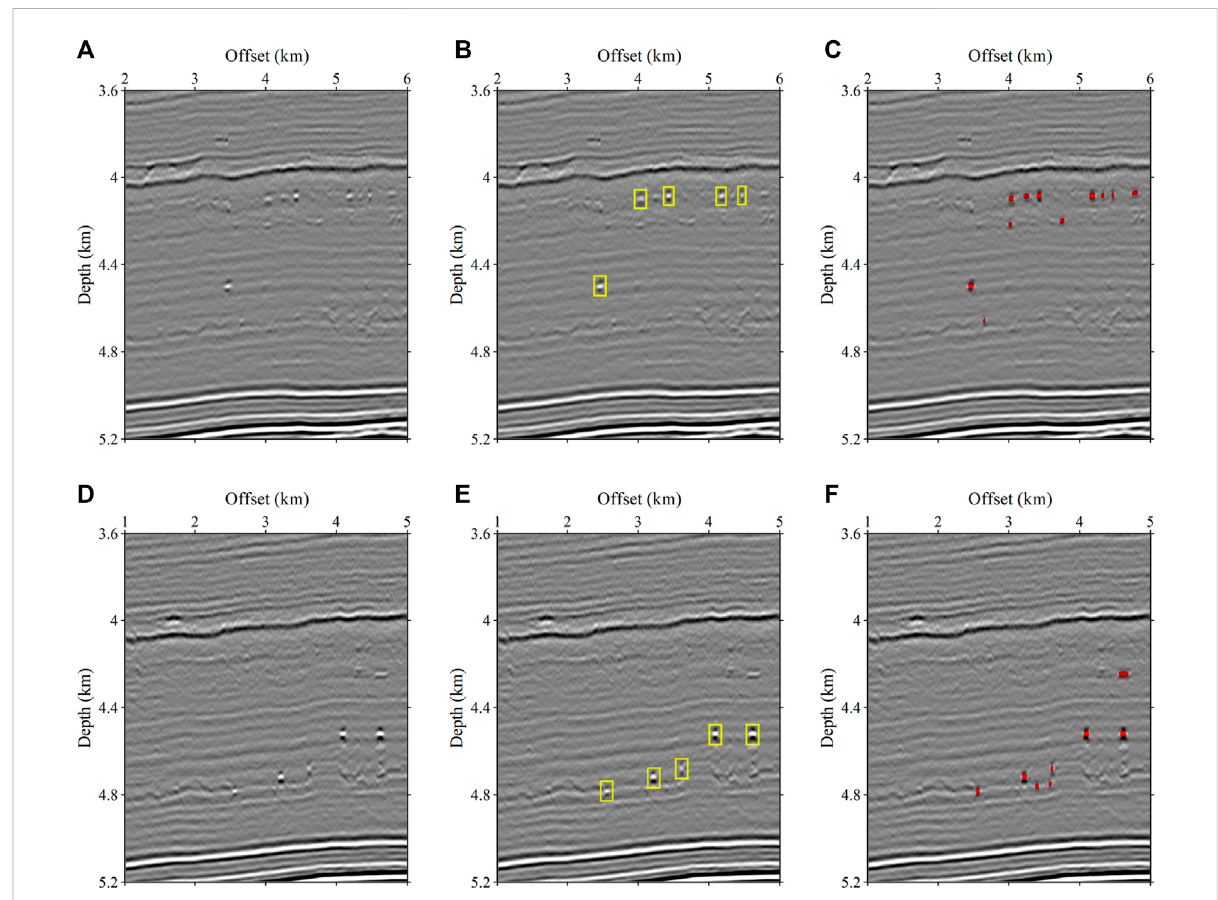
FIGURE 15 The imaging results and prediction results of the physical simulated data on the inline section. The symbols are the same as in Figure